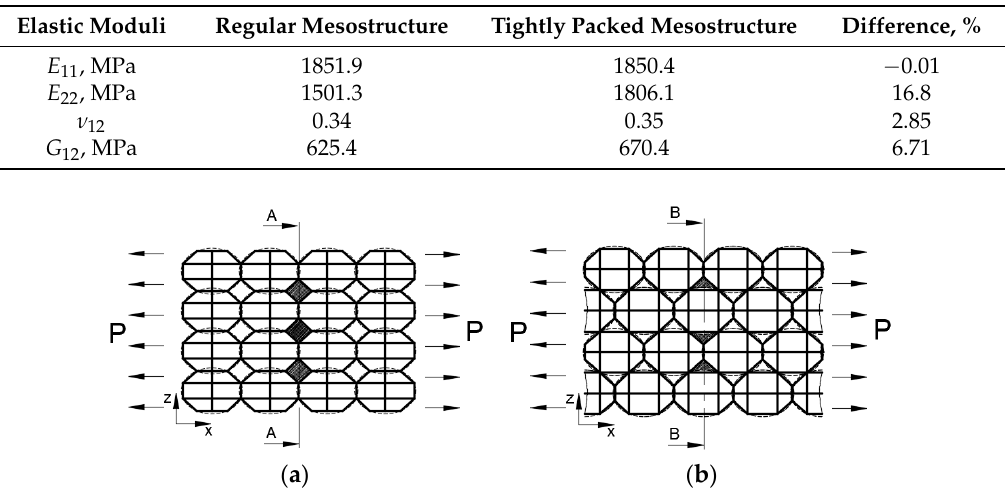
Table 3. Layer properties of the part for regular and tightly packed mesostructure.